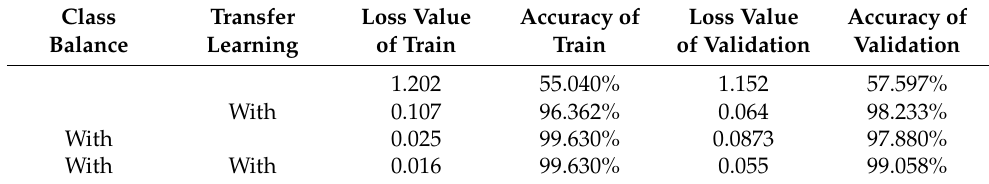
Table 3. Results of ablation experiment.